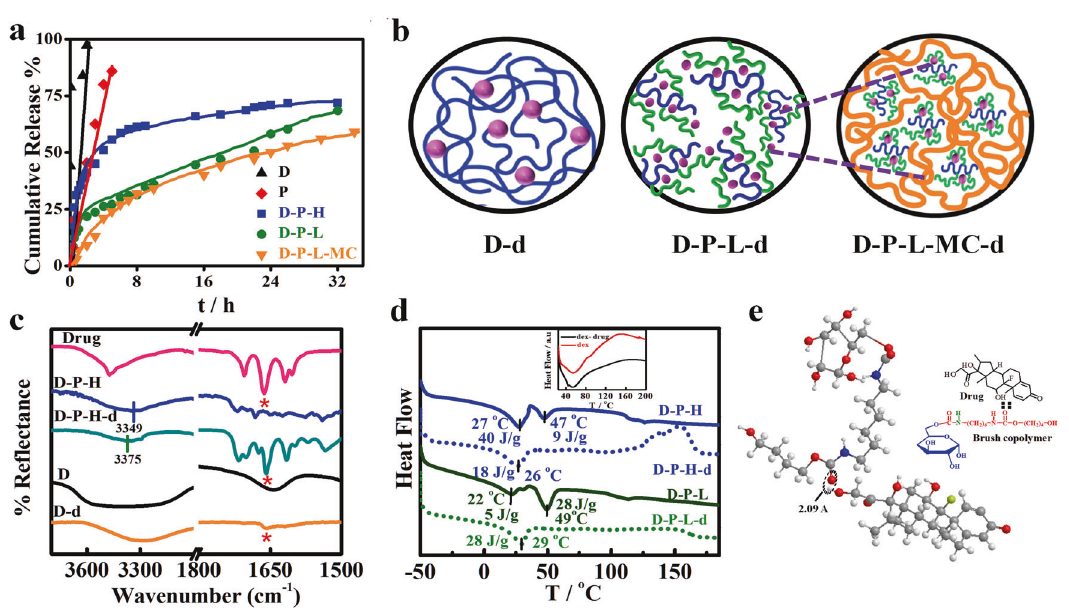
Fig. 3 Drug-release pro fi le, release kinetics, and polymer – drug interaction. a Cumulative release of dexamethasone from pure dextrin, indicated brush copolymers and its hydrogel showing sustained drug-release pro fi le. b Schematic model showing how drug is released from various vehicles. Drug-loaded D-P-L is embedded in MC to make it hydrogel. c FTIR spectra of brush copolymers with and without drug loading showing the shifting in peaks as well as appearance of new drug peaks. d DSC thermograms of pure and drug-loaded brush polymers showing shift in melting peak along with heat of fusion. Inset fi gure shows the thermograms of dextrin and drug embedded dextrin. e Simulation of energy-minimized con fi guration of drug and brush copolymer considering one HMDI, one PTMG, and one dextrin unit through semi-empirical AM1 method. The minimum distance between urethane carbonyl of brush copolymer and hydroxyl group in drug is 2.09 signifying hydrogen bonding between the two